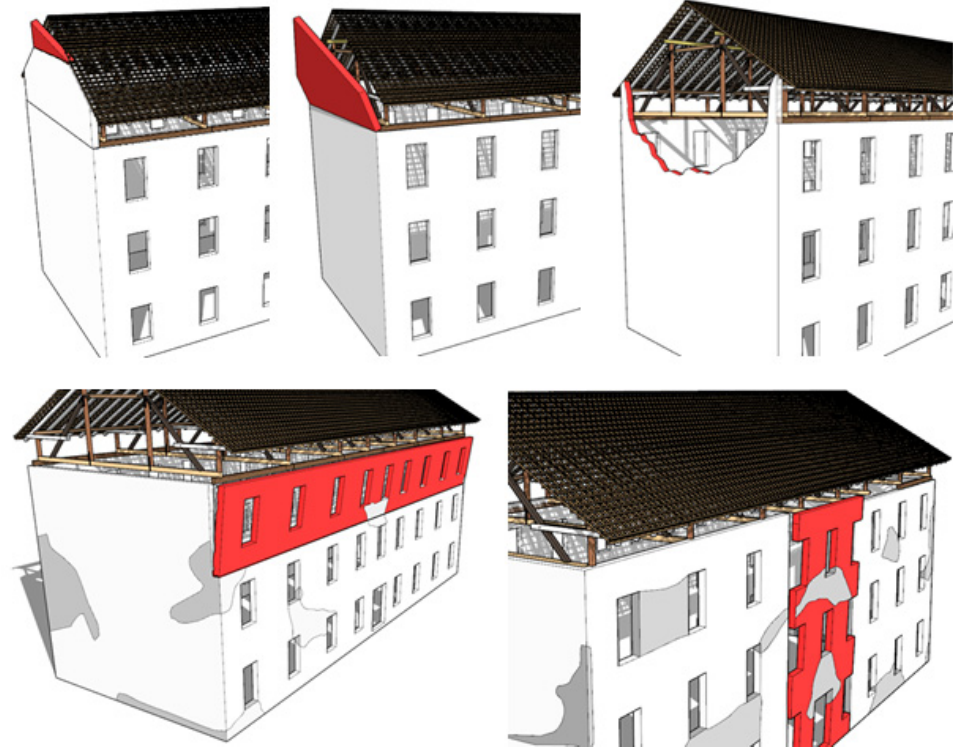
Figure 3. Typical damages to masonry buildings are caused by the homogeneity of timber roof systems and poor connection with masonry walls and elements.